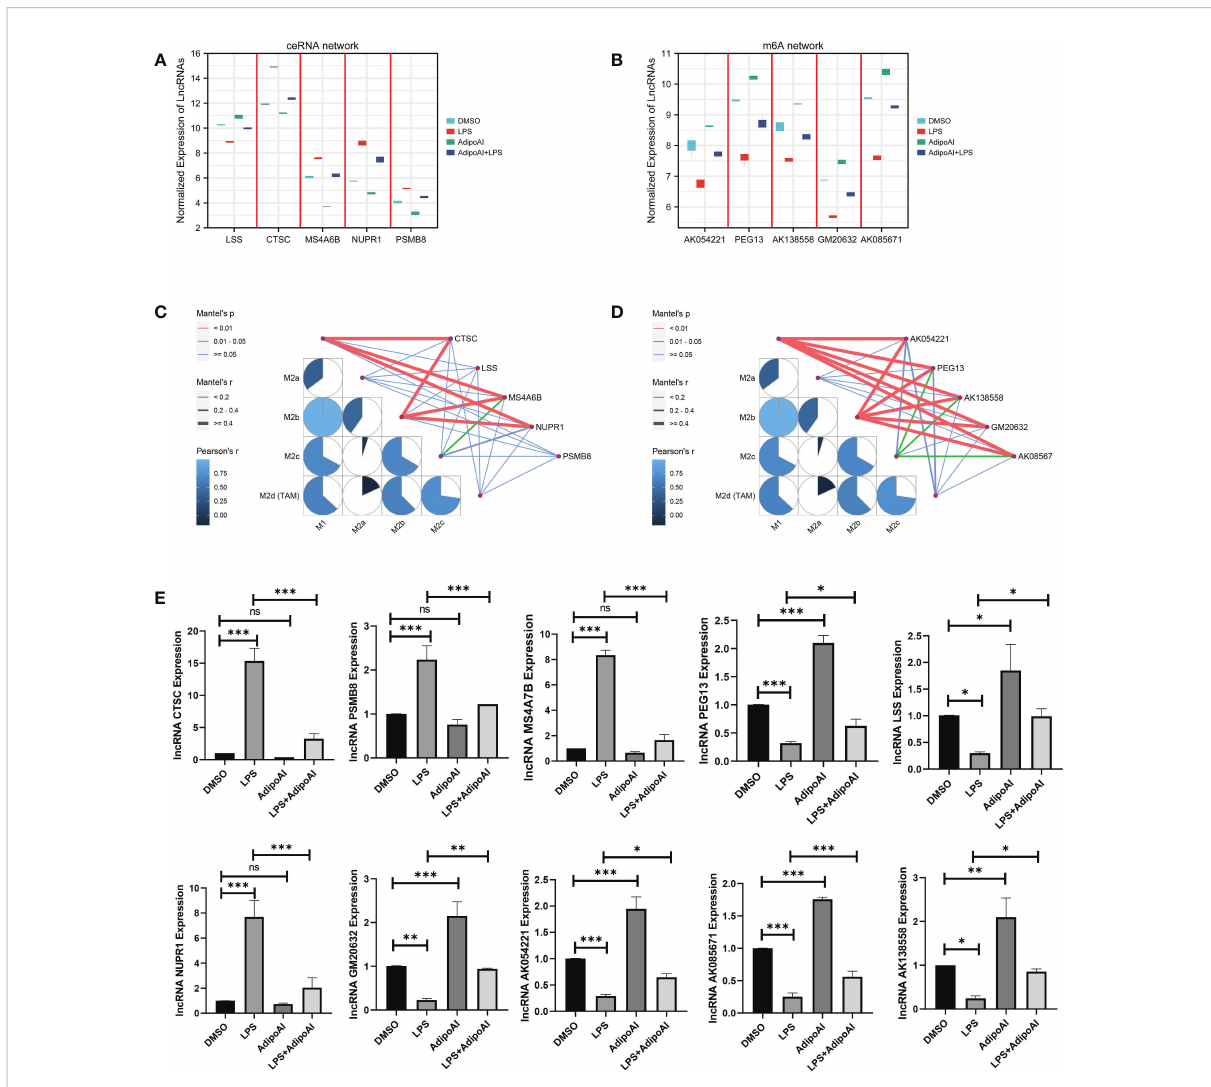
FIGURE 8 Microarray and qRT ‒ PCR validation. (A) Box plot for the expression of 5 lncRNAs selected in ceRNA networks. (B) Box plot for the expression of 5 lncRNAs selected in the m6A-regulated lncRNA ‒ mRNA networks. (C, D) Mantle order test of lncRNAs selected from the ceRNA- and m6A- related DElncRNA networks. (C) ceRNA networks, (D) m6A-related DElncRNA networks. (E) qRT ‒ PCR validation for 10 lncRNAs (n=3). ns: no signi fi cant, * P <0.05, ** P <0.01, *** P